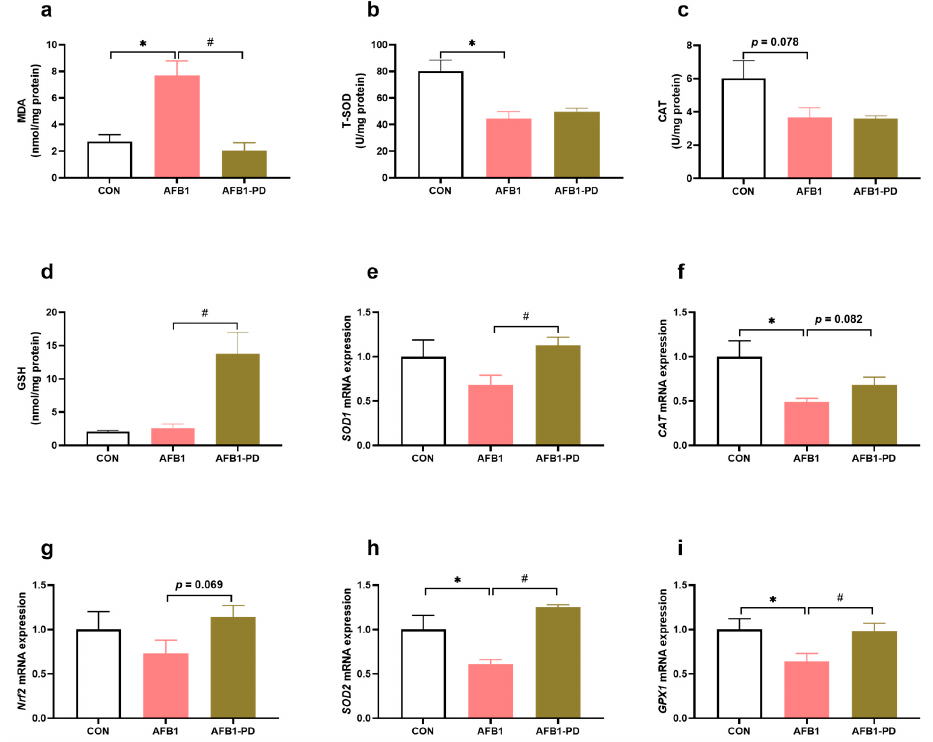
Figure 2. Polydatin (PD) reduces hepatic oxidative stress in a fl atoxin B1 (AFB1) mice. ( a ) Malondialdehyde (MDA, n = 6) concentration; ( b ) total superoxide dismutase (T-SOD, n = 6) activity; ( c ) catalase (CAT, n = 6) activity; ( d ) glutathione (GSH, n = 6) level; ( e – i ) the mRNA expression of SOD1 , CAT , nuclear factor erythroid 2-related factor 2 ( Nrf2 ), SOD2 and glutathione peroxidase 1 ( GPX1 ) (n = 5). CON, mice are given 0.5% dimethyl sulfoxide; AFB1, mice are given 300 µg AFB1/kg body weight/day; AFB1-PD, mice are given 100 mg PD/kg body weight/day and then exposed to AFB1. Results are represented as mean and standard error. * p < 0.05 when compared with the CON group, # p < 0.05 when compared with the AFB1